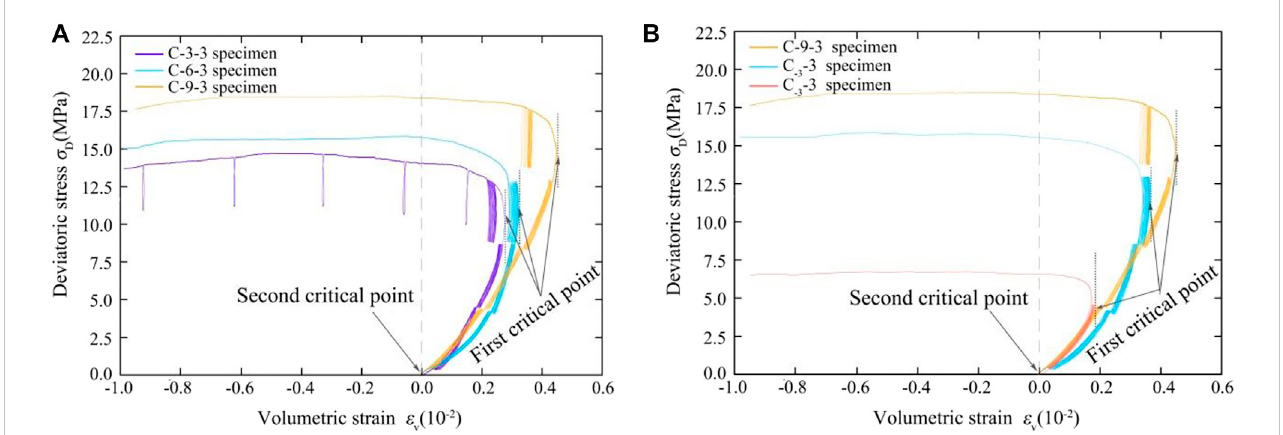
FIGURE 7 Deviatoric stress-volumetric strain ( σ D - ε v ) curves of coal specimens with cyclic loading and unloading at different stress lower limits (A) under different con fi ning pressure; (B) under different unloading